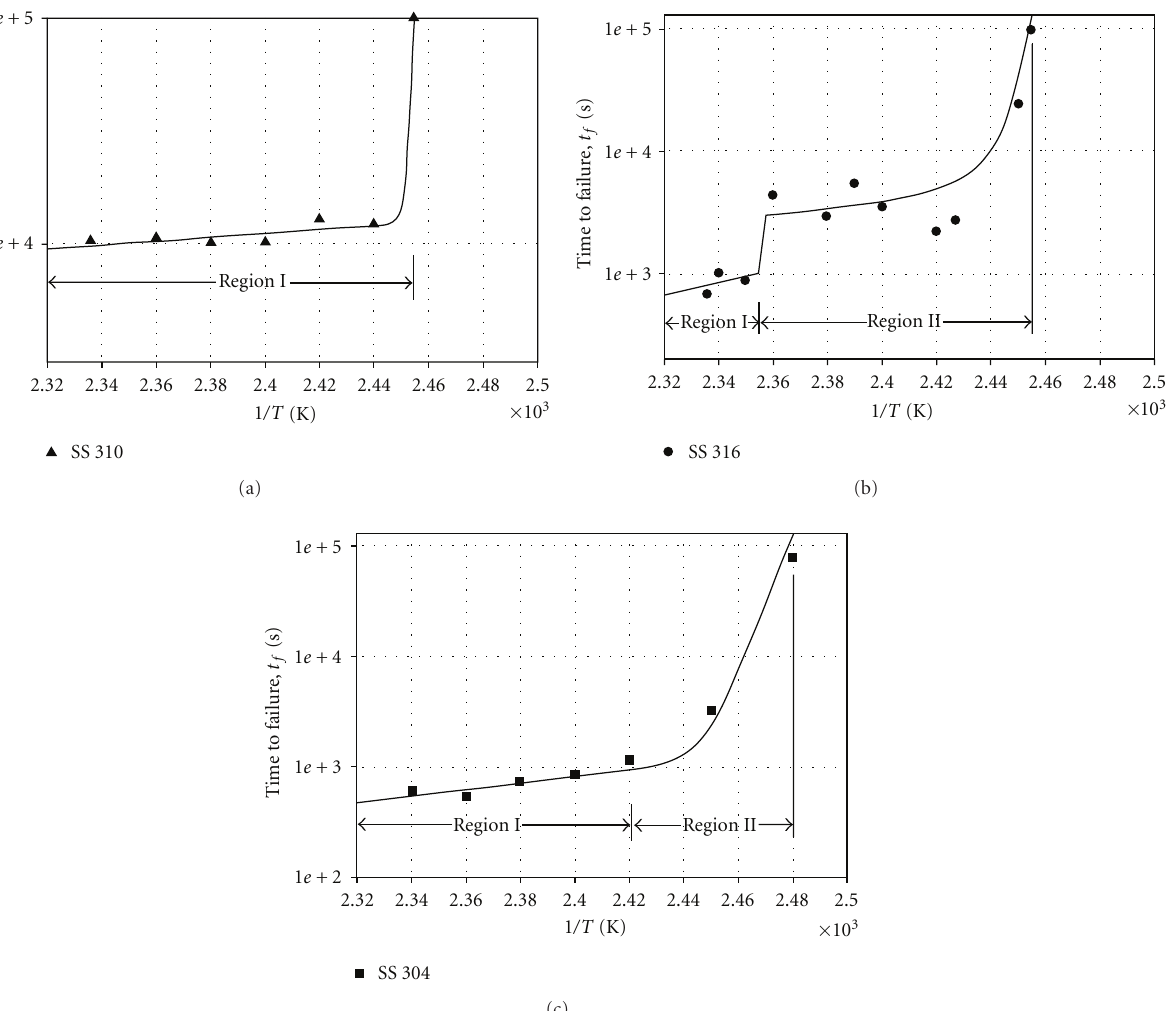
Figure 2: The relationship between reciprocal of test temperature (1 /T ) and logarithm of time to failure ( t f ) for type 310, 304, and 316 steels in boiling saturated MgCl 2